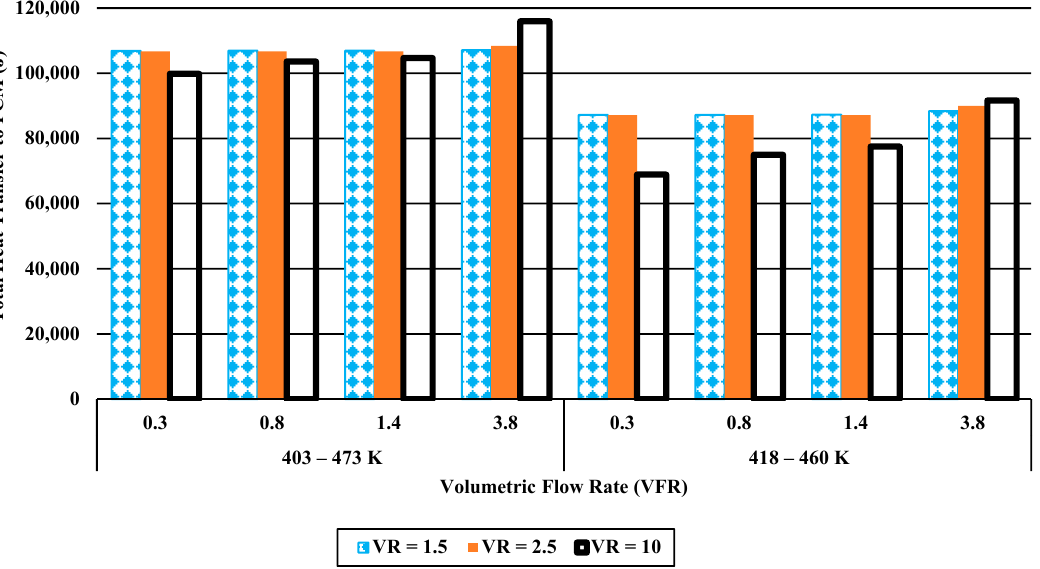
Figure 11. Heat Transfer rate variation to the PCM in terms of HTF inlet temperature, volume ratio and flow rate (VFR is in m 3 /h).